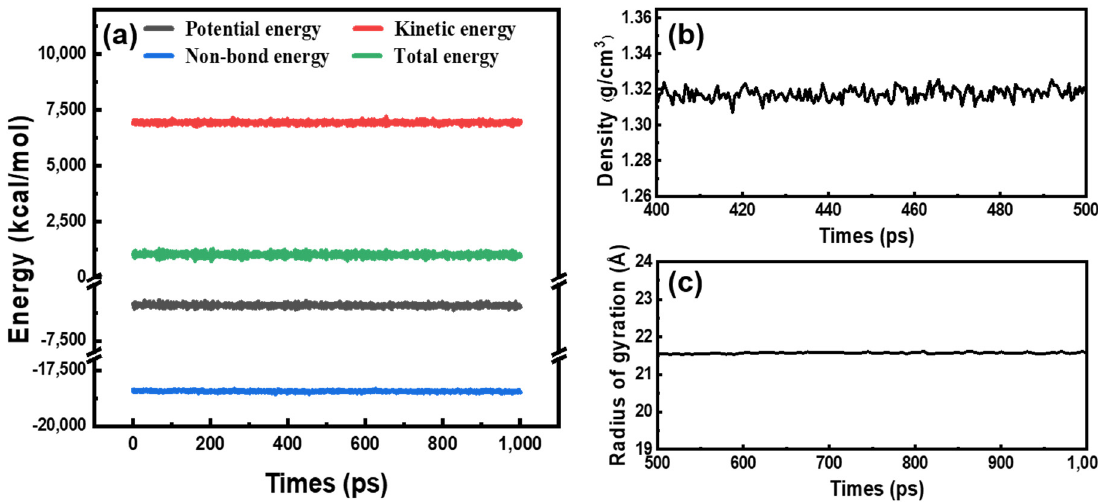
Figure 1. ( a ) Energy curves of the models; ( b ) density curve of the models; and ( c ) radius of gyration curve of the models (example is PMDA/4,4 ′ -ODA).